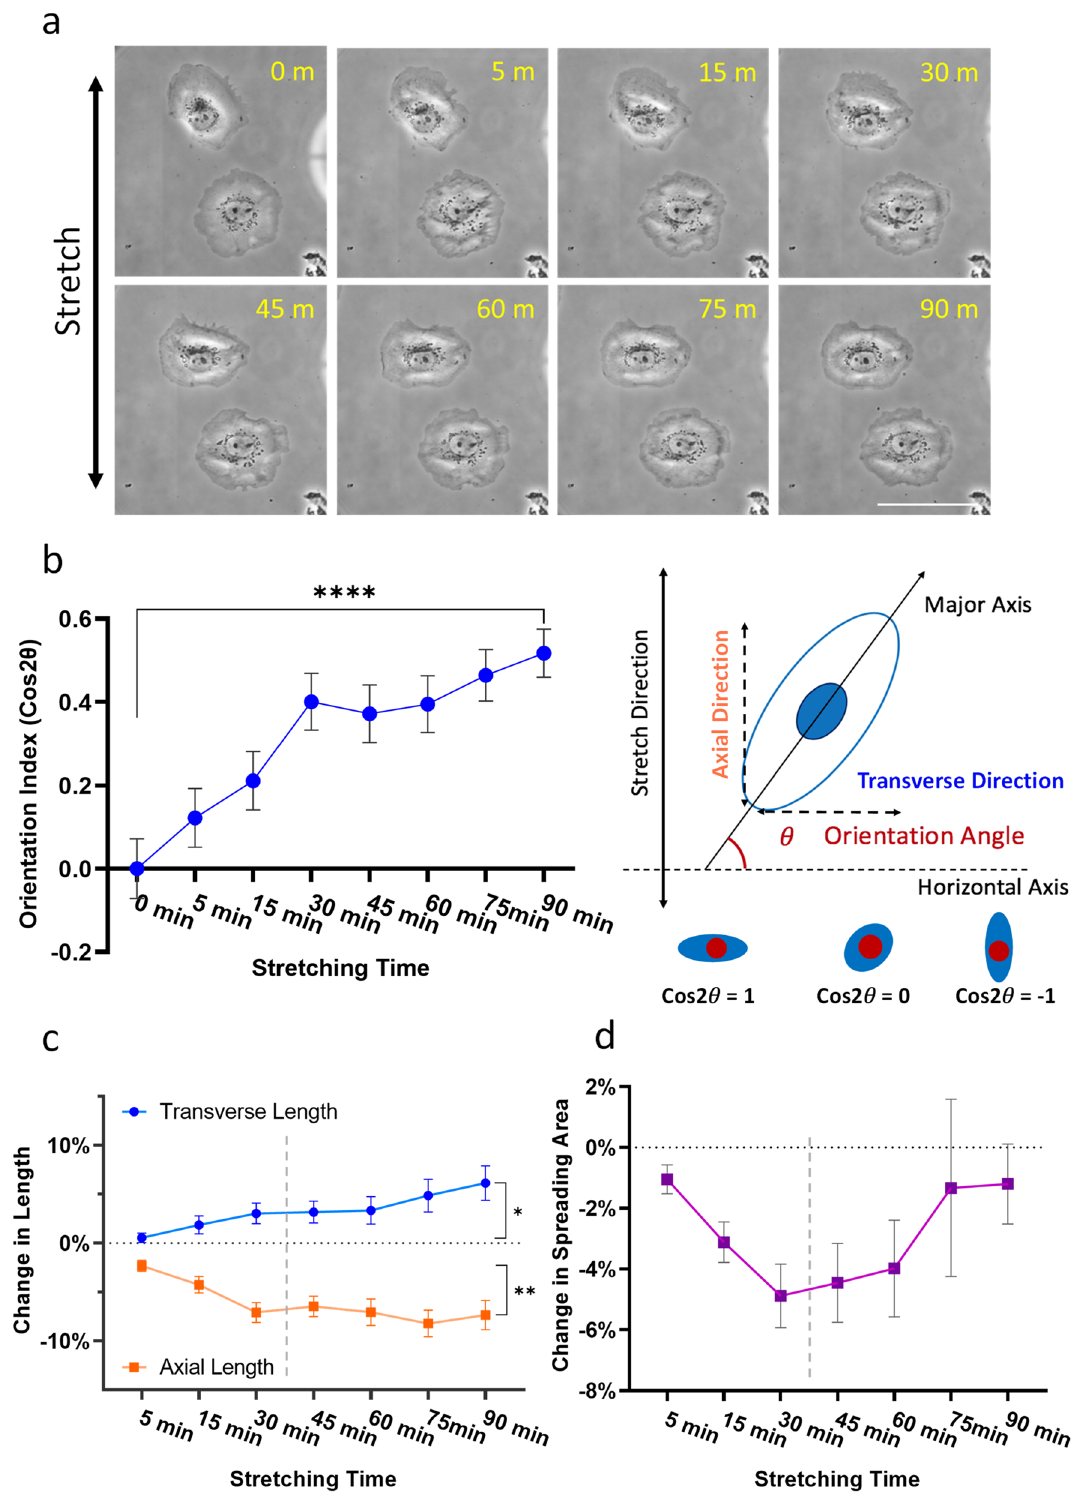
Figure 2. Changes in shape, orientation, and area of NRK-52E epithelial cells in response to uniaxial cyclic stretching. ( a ) Isolated NRK-52E cells show visible shape change and reorientation perpendicular to the direction of stretching over 90 min of stretching (scale bar, 100 μm). ( b ) Orientation index is calculated as cos2θ where θ is the angle between the major axis of the cell and the transverse direction. Transverse orientation, detectable as early as 5 min after the initiation of cyclic stretching, increases steadily over a period of 90 min. ( c , d ) Corresponding changes in cell length along axial and transverse directions, and in spreading area, are also observed during 90 min of cyclic stretching. Shape change is driven primarily by shortening along the axial direction during the first 30–45 min of cyclic stretching, in conjunction with a slow but continuous increase in transverse length and recovery in spreading area between 45 and 90 min ( c , d ). The two distinct phases before and after 30–45 min are indicated by vertical dashed lines (* p < 0.05; ** p < 0.01; **** p < 0.0001; n = 82, mean ±